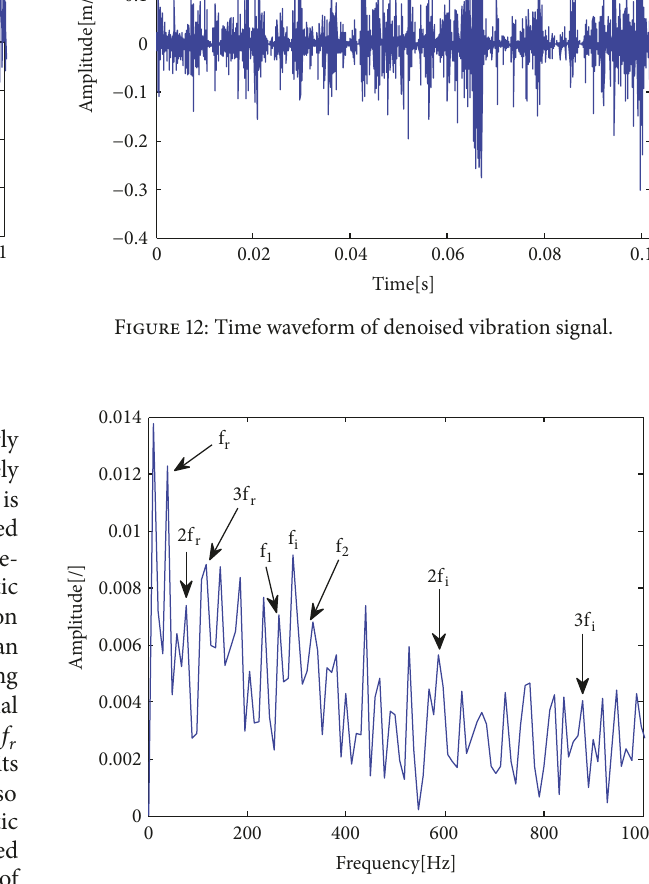
Figure 13: Envelop spectrum of denoised vibration